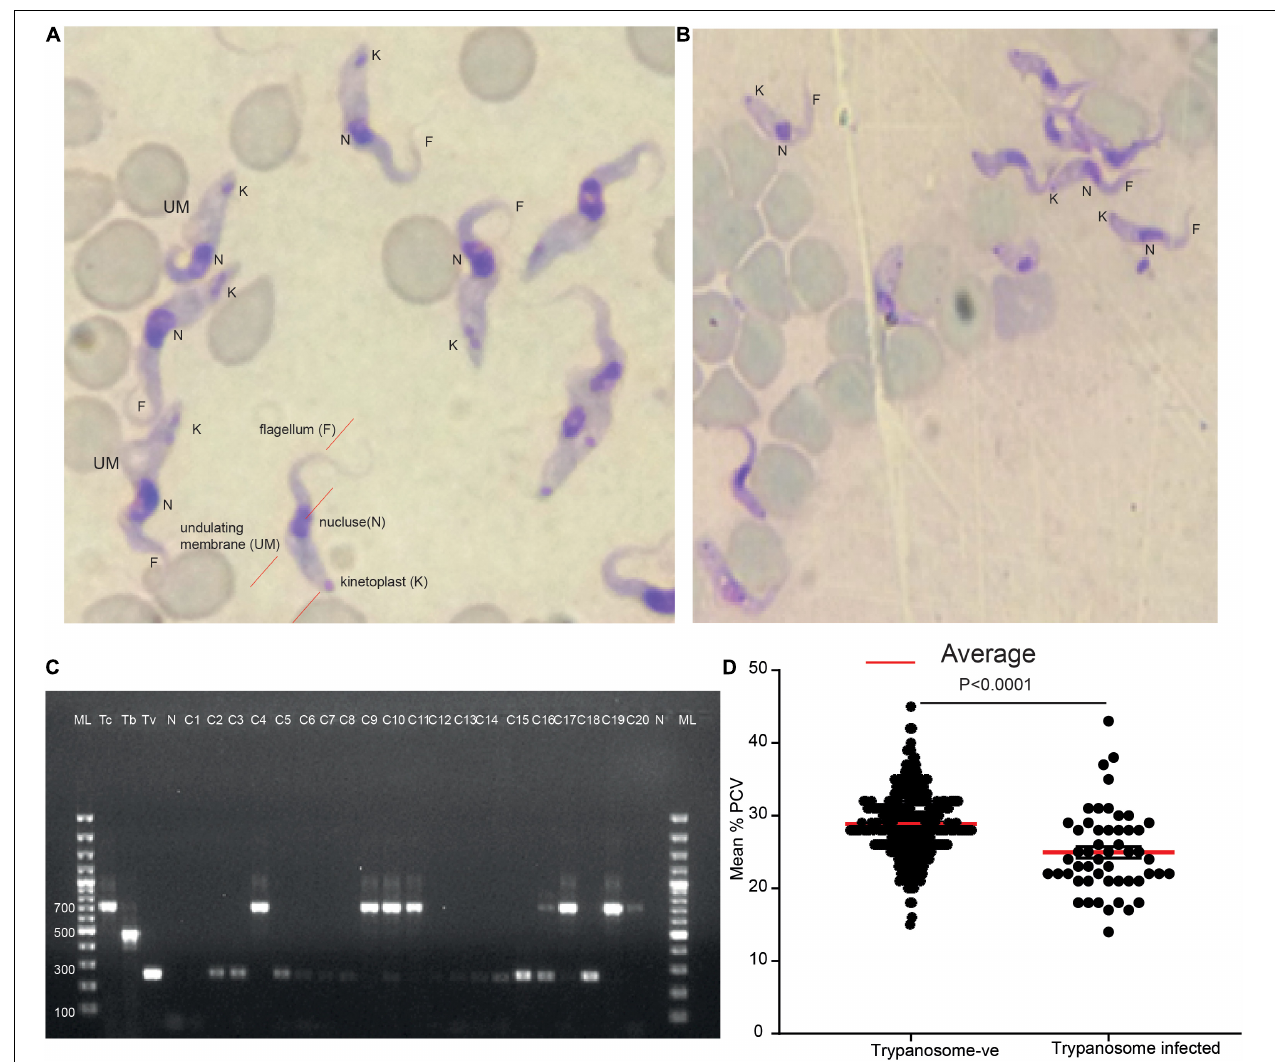
FIGURE 1 | Two major trypanosome species were detected from naturally infected cows. (A) Representative light micrographs of Giemsa-stained cow blood sample smears infected with T. vivax (look the wavy shape and long flagellum). (B) Representative light micrograph of Giemsa-stained cow blood sample smears infected with T. congolense showing the less wavy shape and shorter in length flagellum. (C) Molecular confirmation of the two trypanosomes. ML 100 bp marker, Tc +ve control for T. congolense , Tb, T. brucei , and Tv, T. vivax , and N, negative control, C1–C20 cows blood sample. (D) The mean PCV of cow microscopically trypanosome negative and positive from field samples, n =